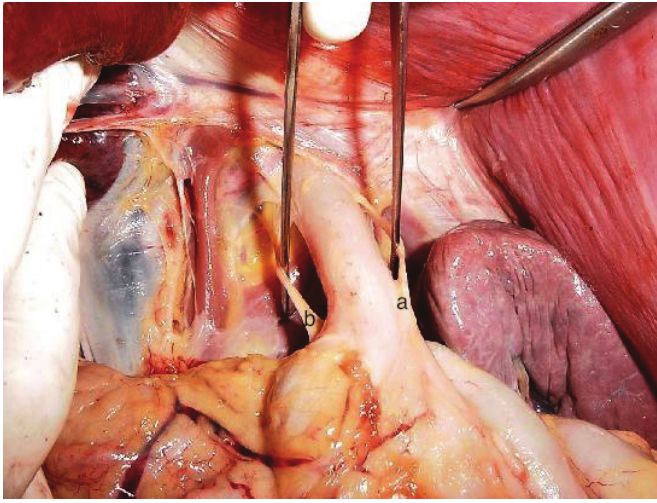
FIgURE 3 - anterior ( a ) and posterior ( b ) vagus nerve branches dissected from the esophageal body before vagotomy.